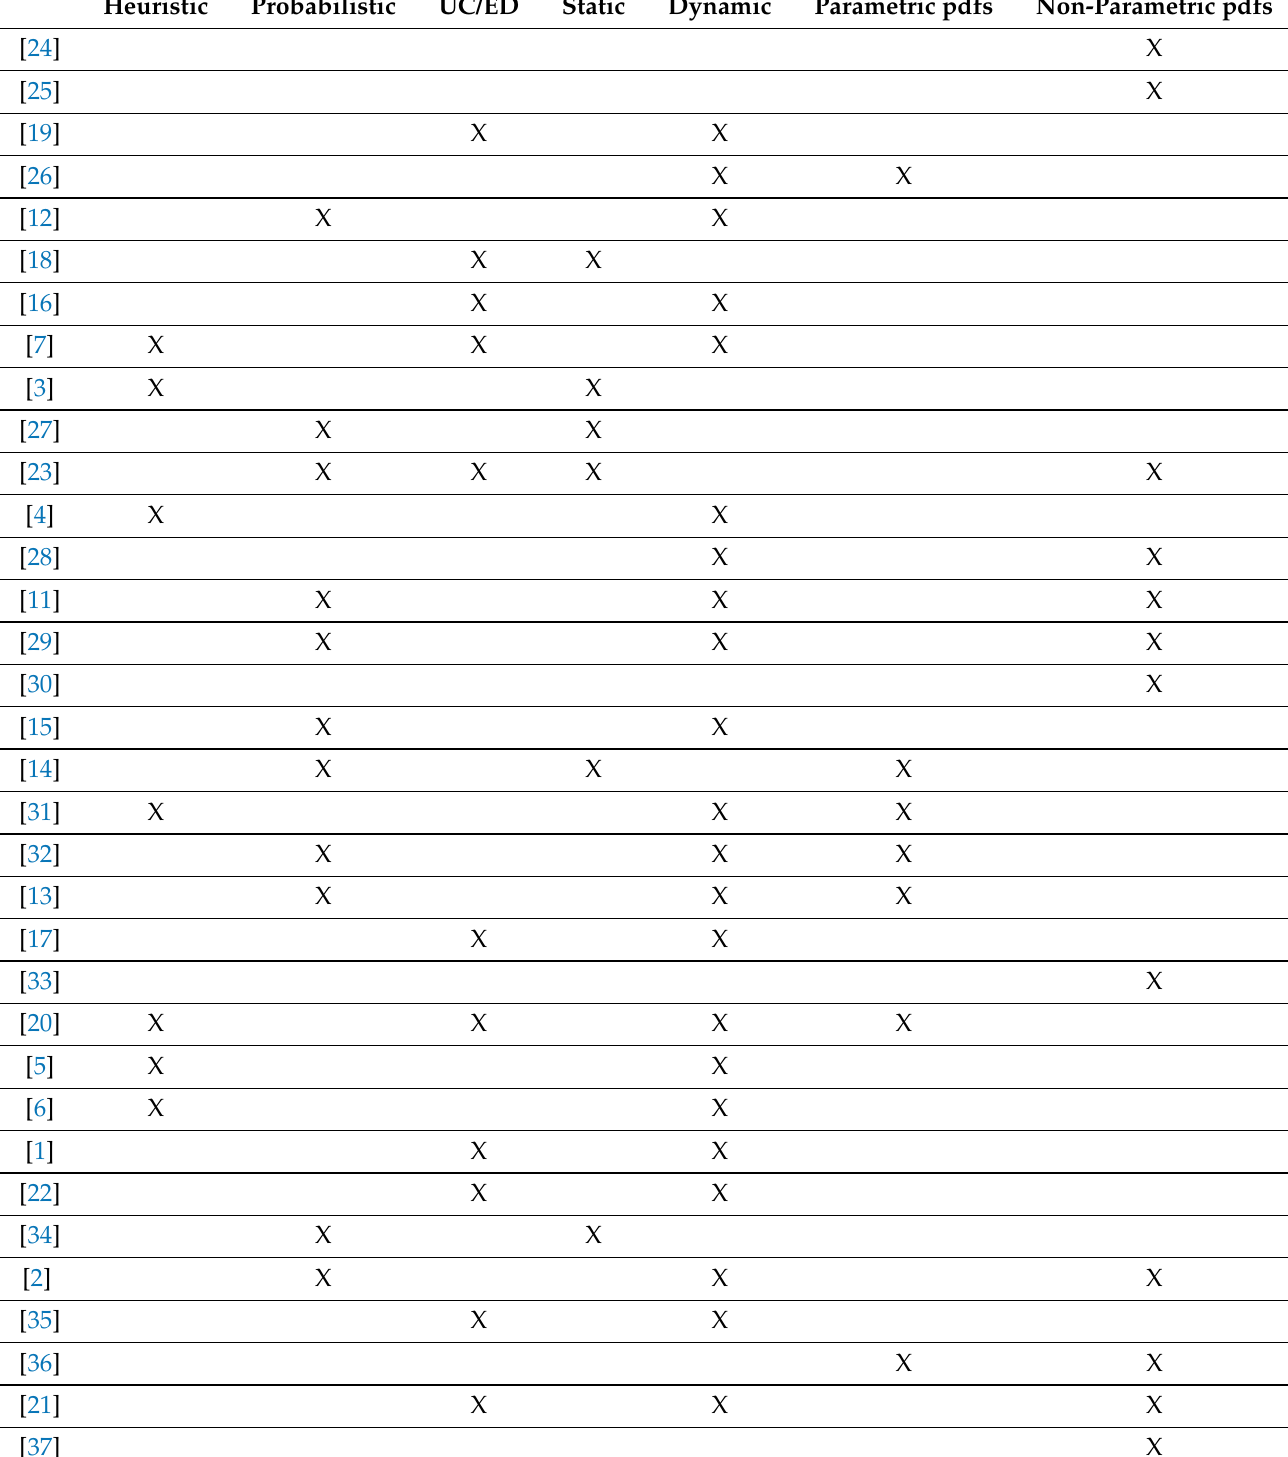
Table 1. A classification of reserve sizing